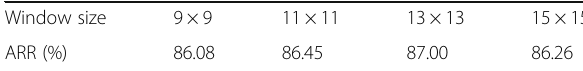
Table 2 Performance of the proposed method with various window sizes on Outex database